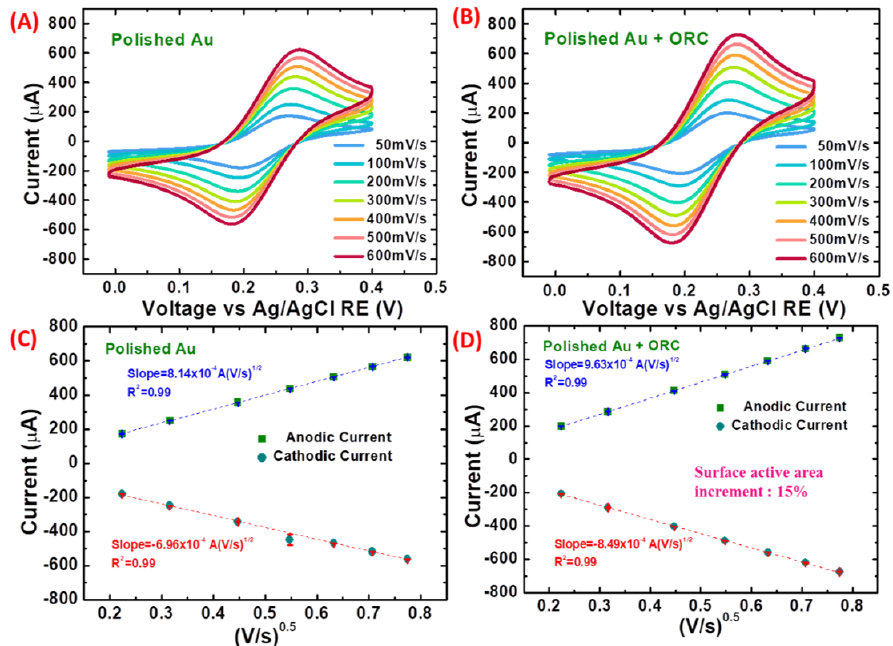
Figure 4. Cyclic voltammograms (CV) run between 0 and 0.4 V in 5 mM K 3 [Fe(CN) 6 ]/K 4 [Fe(CN) 6 ] and 0.5 M KCl at various scan rates of polished Au surface ( A ) without and ( B ) with ORC treatment. The relation of the anodic peak current on the scan rate square root with the calculated correlation coefficient for polished Au surface ( C ) without and ( D ) with ORC treatment.